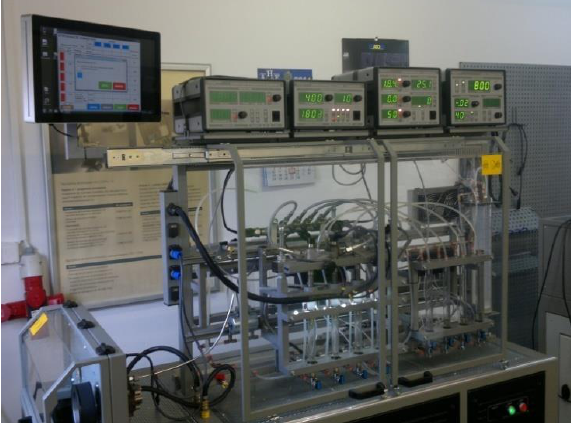
Fig. 4. Diesel Bench STPiW-3 main diagnostic test